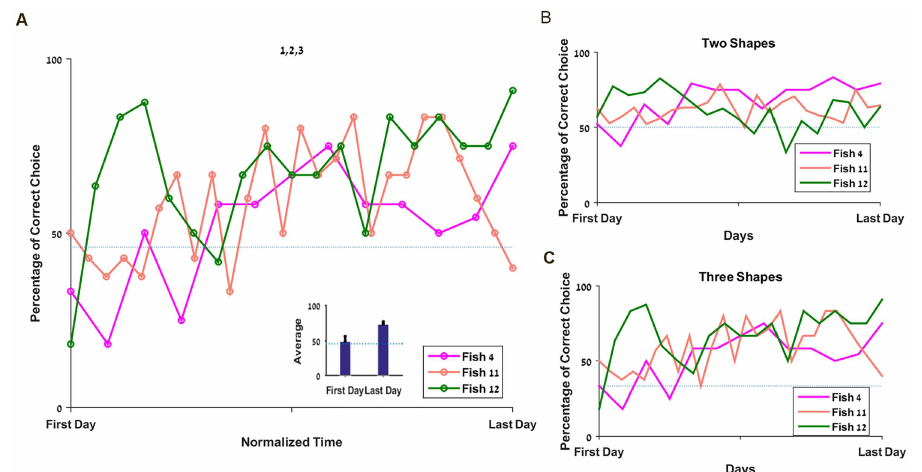
Fig 5. Fish can associate three values and with three shapes. A . Success rate for each fish on the 1, 2, 3 experiment over normalized time. Inset: averagesuccess rate on the first and last day. The dashedline represents the chance level (45 . 83%) . B . Success rate for the three combinations with two targets. The dashedline represents the chance level (50%) . C. Success rate for the combination with three targets presented simultaneously. The dashedline represents the chance level (33%)